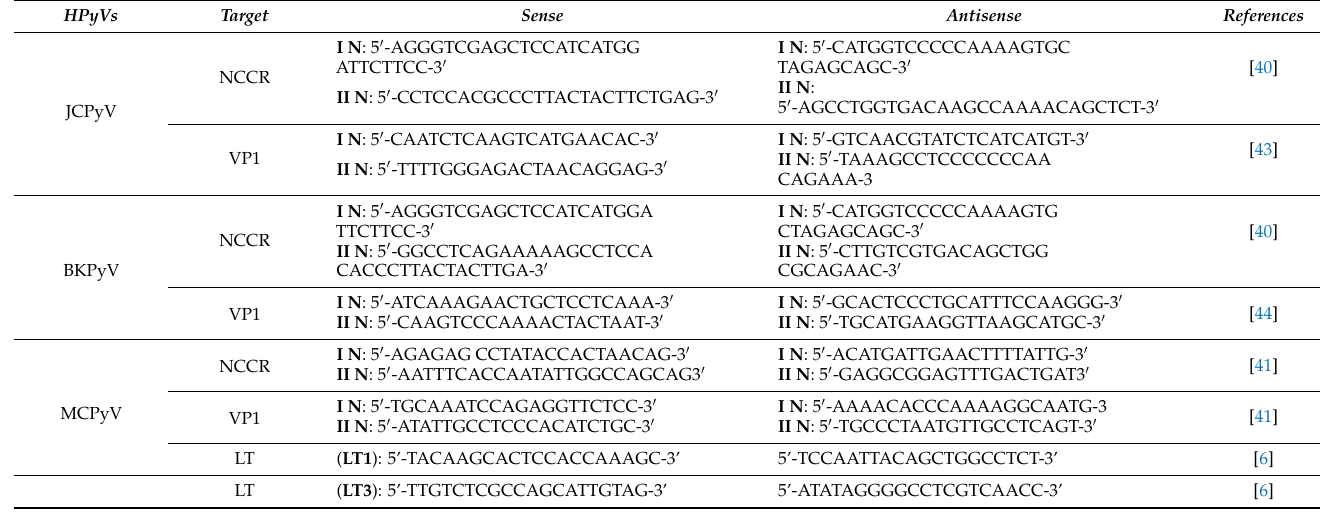
Table 3. Primers employed in qualitative PCR to amplify NCCR, VP1 and MCPyV LTAg